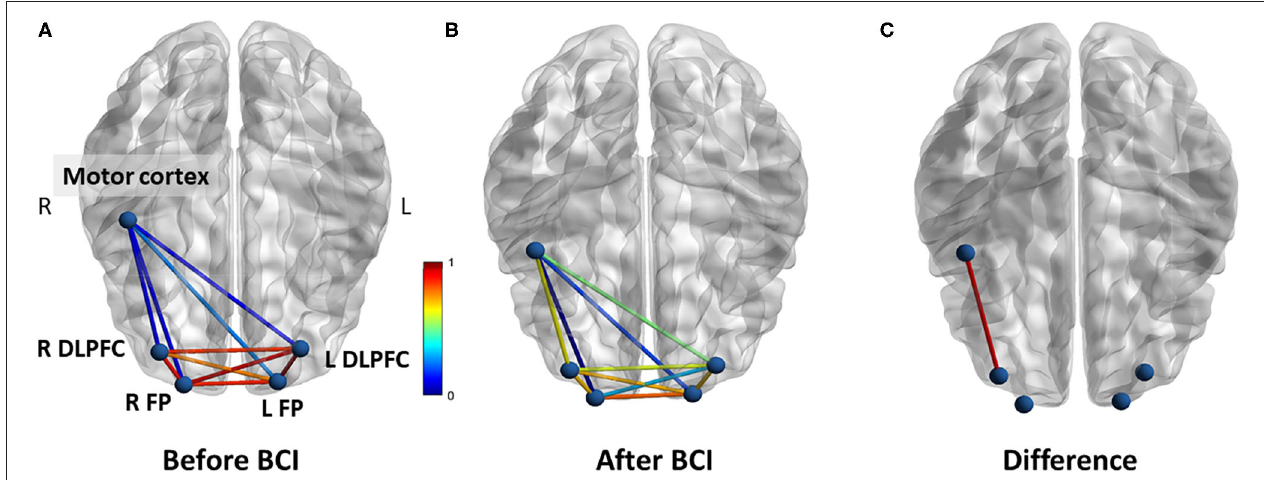
FIGURE 7 | Functional connectivity (correlation) change measured at rest in BCI-only session. (A) Correlations between each ROI at baseline. (B) Correlations between each ROI after BCI training. (C) The correlation between right motor cortex and right DLPFC was significantly increased after BCI training. L refers to left. R refers to right. DLPFC refers to dorsal lateral prefrontal cortex. FP refers to frontal polar